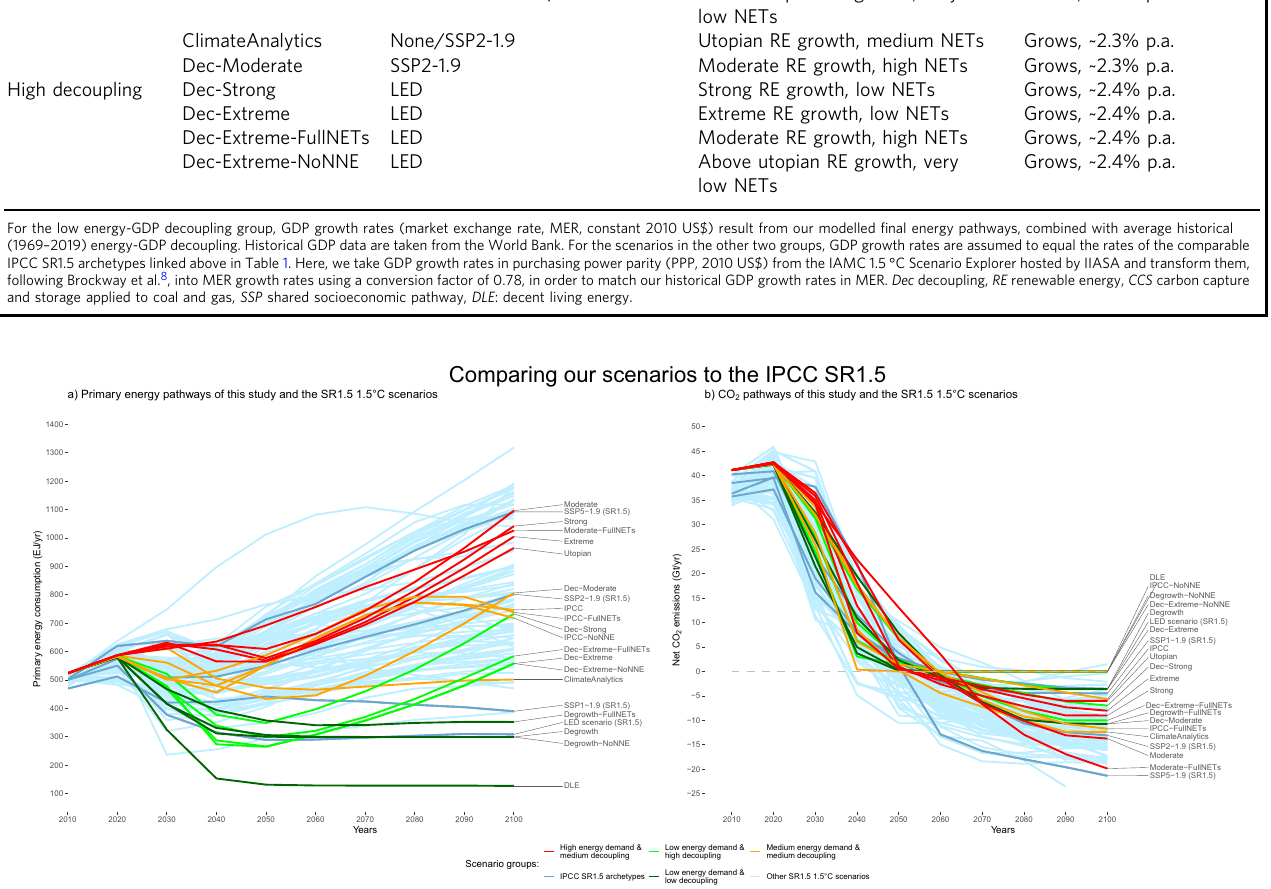
Fig. 1 Comparison of scenarios in this study to the IPCC SR1.5. Comparison of the primary energy a and net CO 2 b pathways of the IPCC SR1.5 1.5 °C scenarios and our scenarios. Data for IPCC pathways are taken from the IAMC 1.5 °C Scenario Explorer hosted by